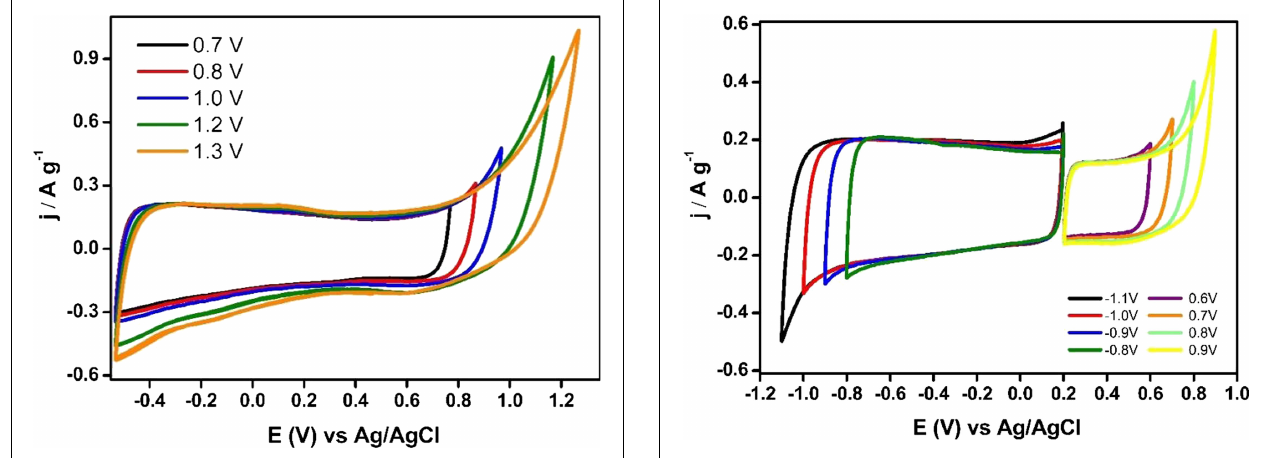
FIGURE 7 | Steady voltammograms for Ank4 sample from E OCP to positive and negative potential values ( υυυ = 1mVs (cid:0) 1 ; 0.5M Na 2 SO 4 )